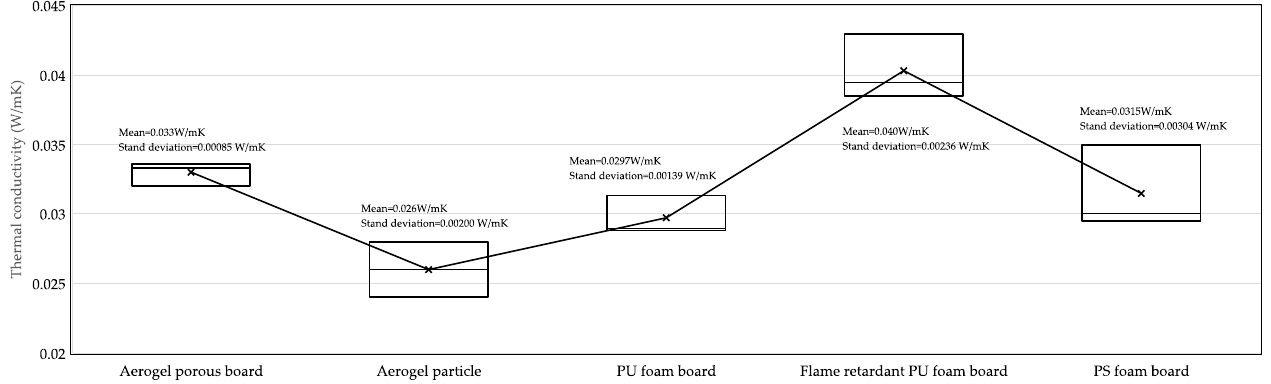
Figure 6. Comparison of the thermal insulation property between the aerogel porous board and commercially available materials.